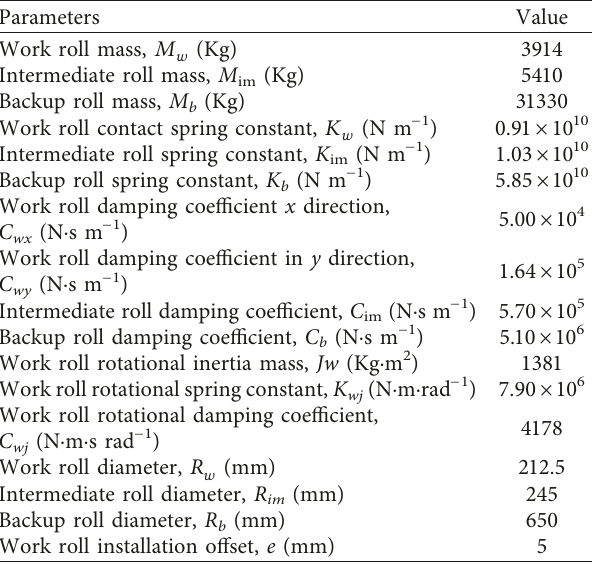
Table 2: Structure specifications of the UCM